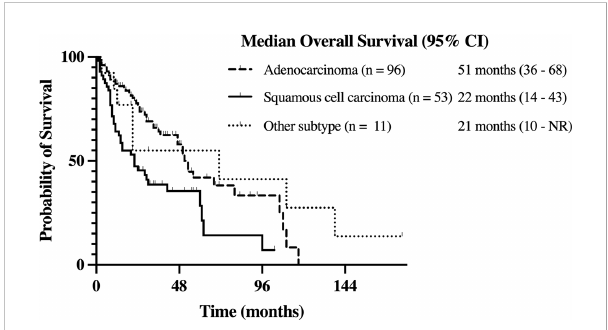
FIGURE 2 Kaplan-Meier estimate of overall survival (OS) in stage III NSCLC patients with adenocarcinoma, squamous cell carcinoma, and other history types.